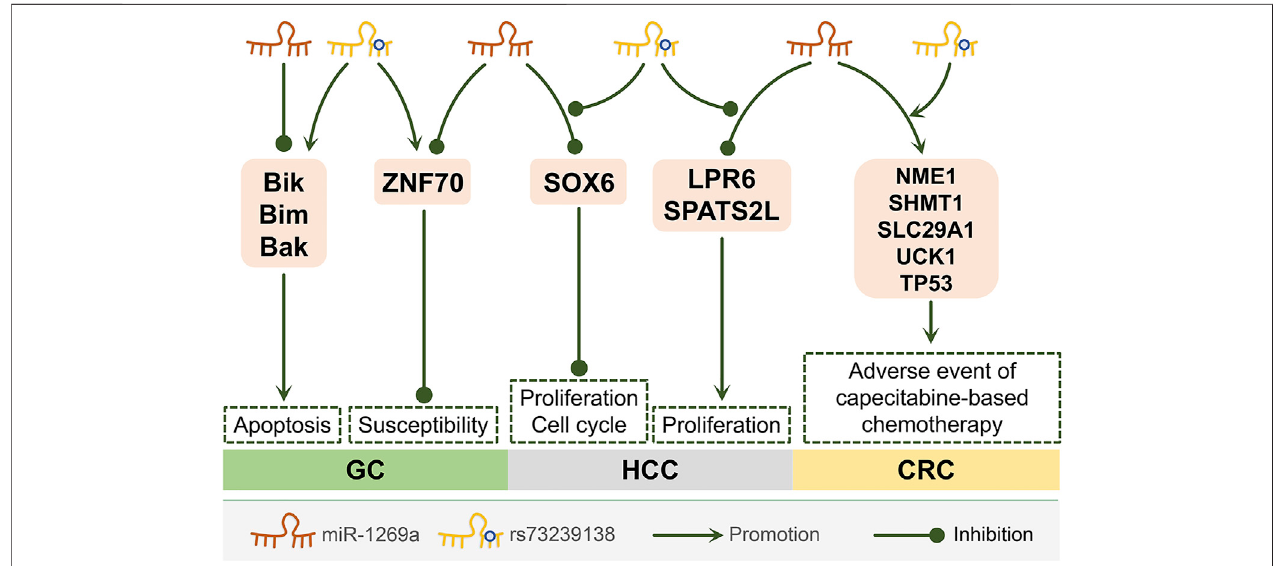
FIGURE4| Themolecular mechanismofmiR-1269ars73239138indifferentcancers. miR-1269ars73239138can affectthreecancersthrough fi vemolecular mechanisms. GC, Gastric cancer; HCC, Hepatocellular carcinoma; CRC, Colorectal cancer. (Li et al., 2017; Xiong et al., 2015; Mao et al., 2017; Min et al., 2017; Wang et al., 2021; Zhu et al., 2008; Dong et al., 2019).